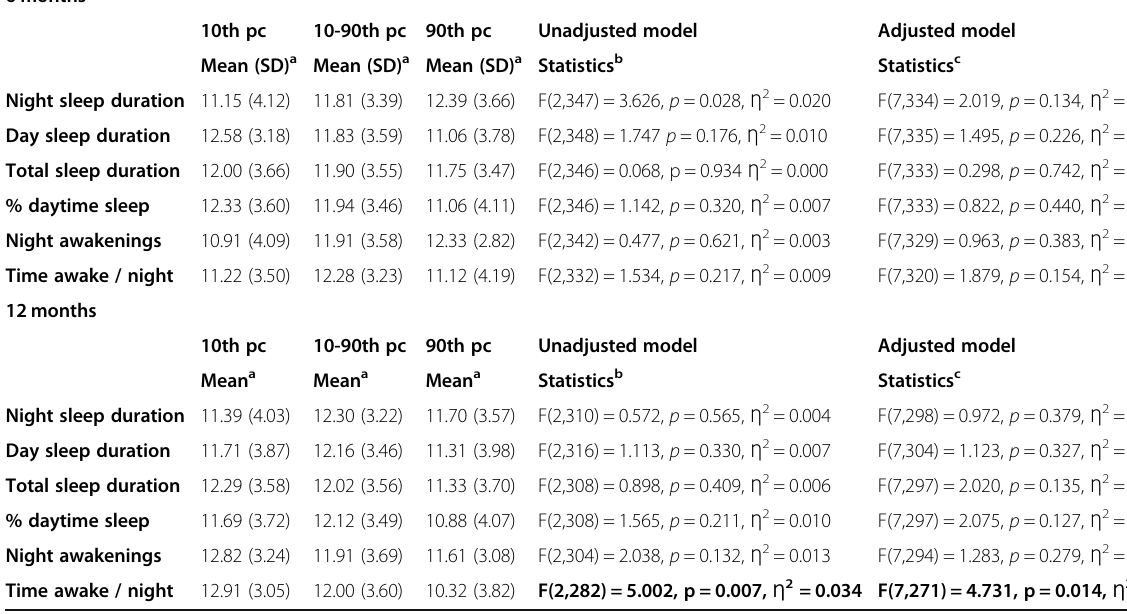
Table 5 The differences between sleep category at 6 months and 12 months in predicting child working memory at 30